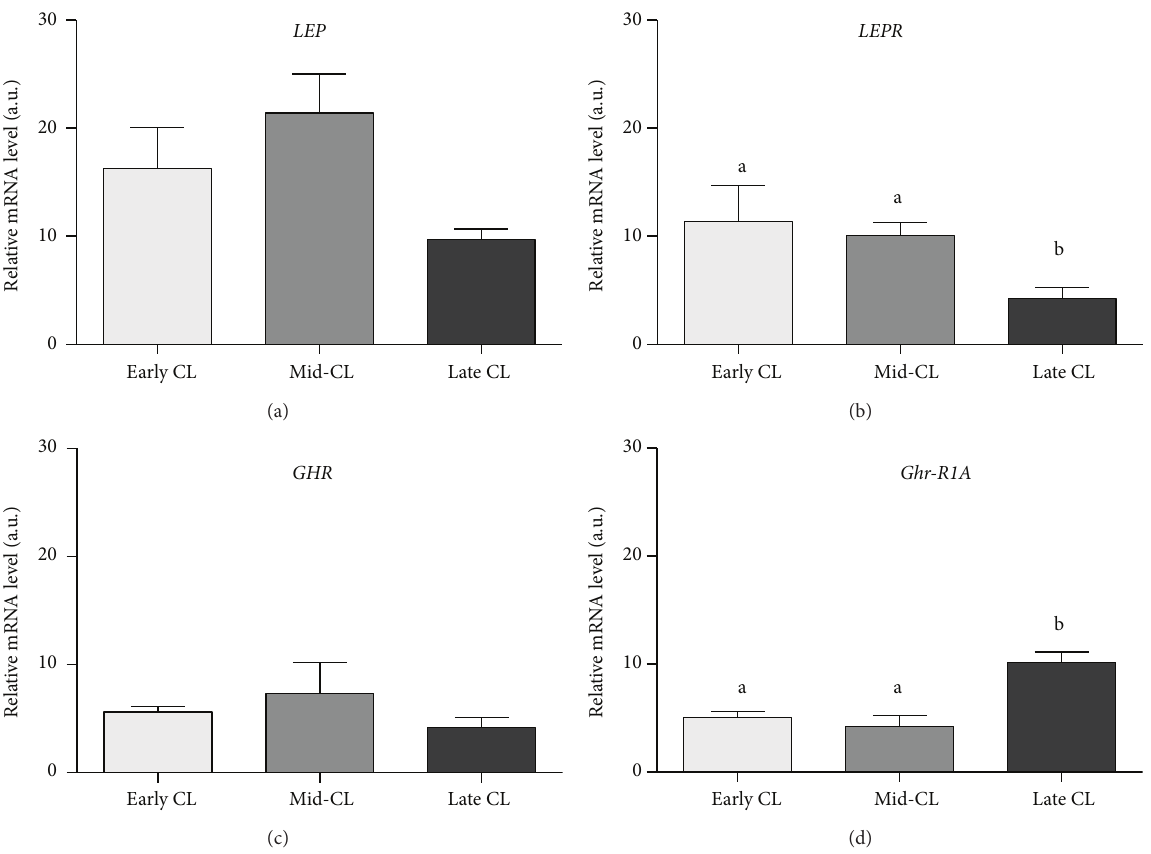
Figure2:Relativequantificationof LEP (a), LEPR (b), GHR (c),and Ghr-R1A and(d)mRNAlevelbyreal-timePCR.Transcriptionnormalized with the housekeeping gene B2MG . Bars represent mean ± SEM. Different letters indicate significant differences ( ∗ 𝑃 < 0.05 ; ∗∗∗ 𝑃 < 0.001 ). of LH treatment responsiveness (positive control) allowed